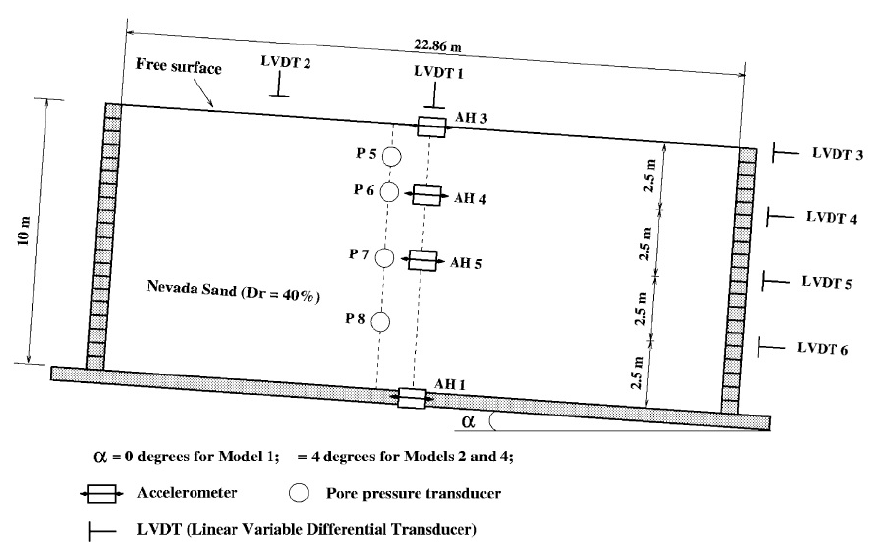
Figure 7. Laminar box container of the Verification of Liquefaction Analysis by Centrifuge Studies